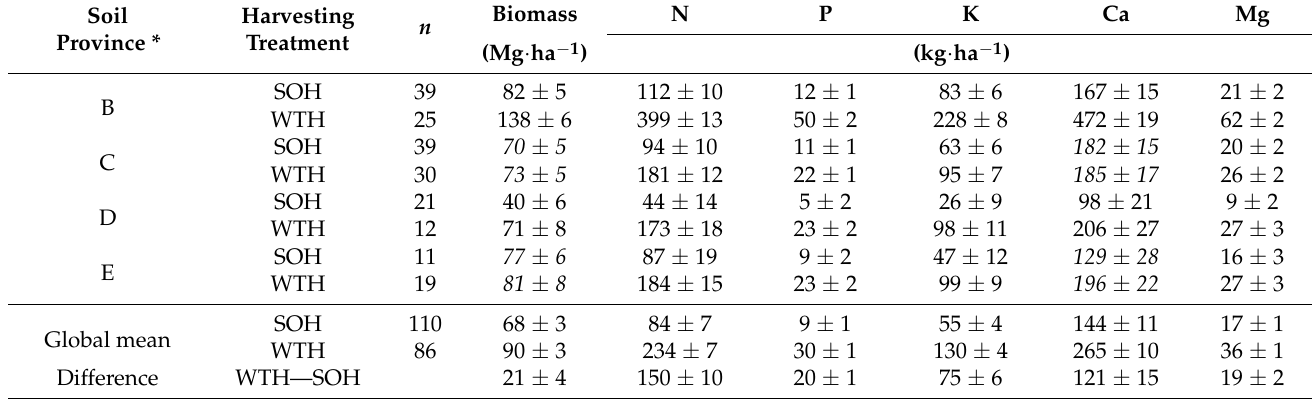
Table 2. Estimated exported biomass and mineralomass, by harvesting treatment (SOH: stem-only harvesting, WTH: whole-tree harvesting) in four soil provinces of Quebec. Data presented are model-adjusted means ± standard errors. Values in bold italics indicate cases where there is NO significant difference between SOH and WTH within a given soil province ( p > 0.05). In all other cases, values for SOH and WTH within a given soil province are significantly different from one another ( p ≤